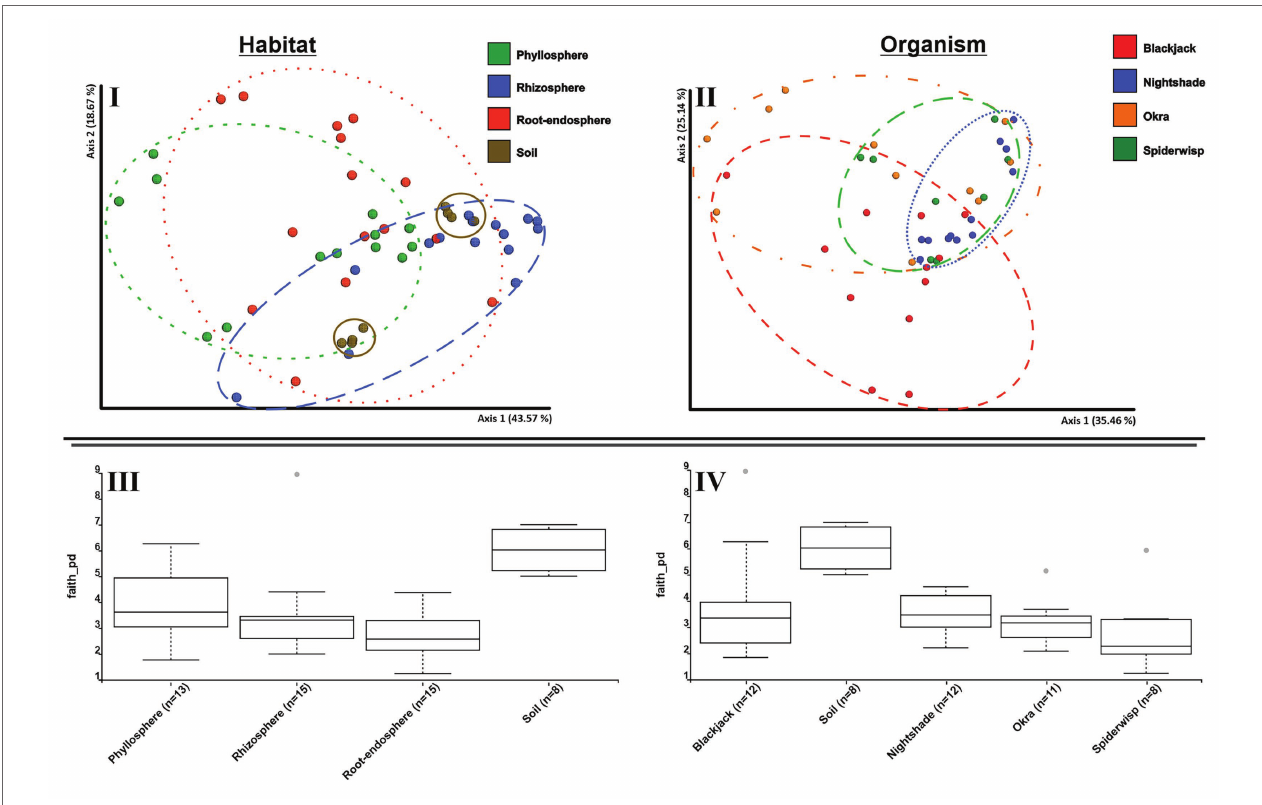
FIGURE 4 | Alpha and beta diversity analyses of archaeal communities associated to leafy green vegetables. PCoA plots based on weighted UniFrac distance metrics show the archaeal community of phyllosphere, rhizosphere, root-endosphere, and soil microhabitats (I) of the four leafy green crops blackjack, nightshade, okra, and spiderwisp (II) ; comparison of alpha diversity based on Faith’s phylogenetic diversity of the microhabitats (III) and plant species (IV)